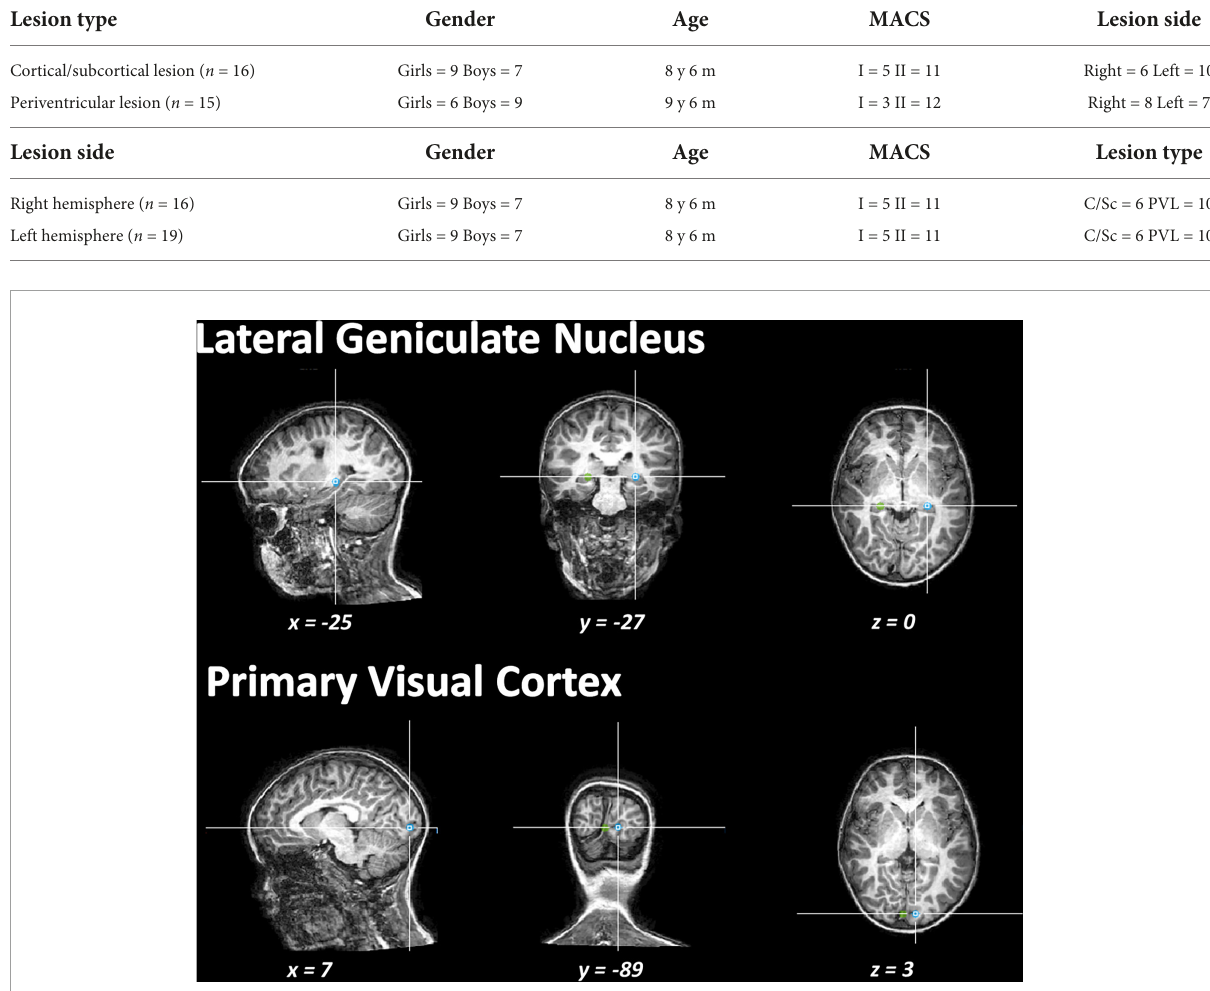
FIGURE1 Illustration of the regions of interest drawn to execute the tracking of the